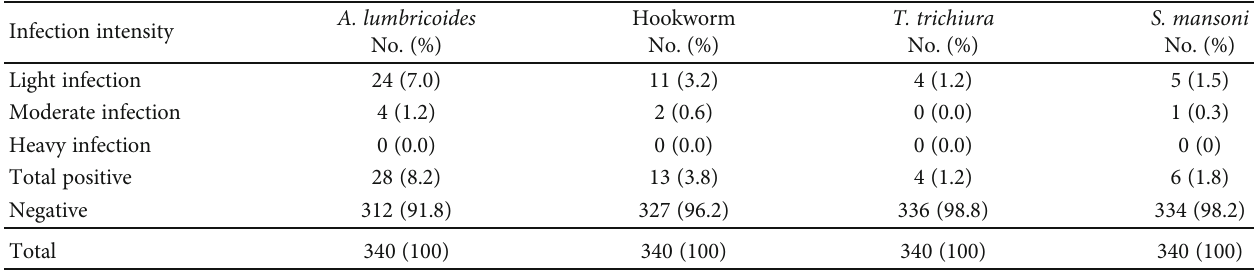
Table 2: Intensity of STH and S. mansoni infections among Hiruy Abaregawi primary school children from March to April, 2019, Debre Tabor town, North West Ethiopia.